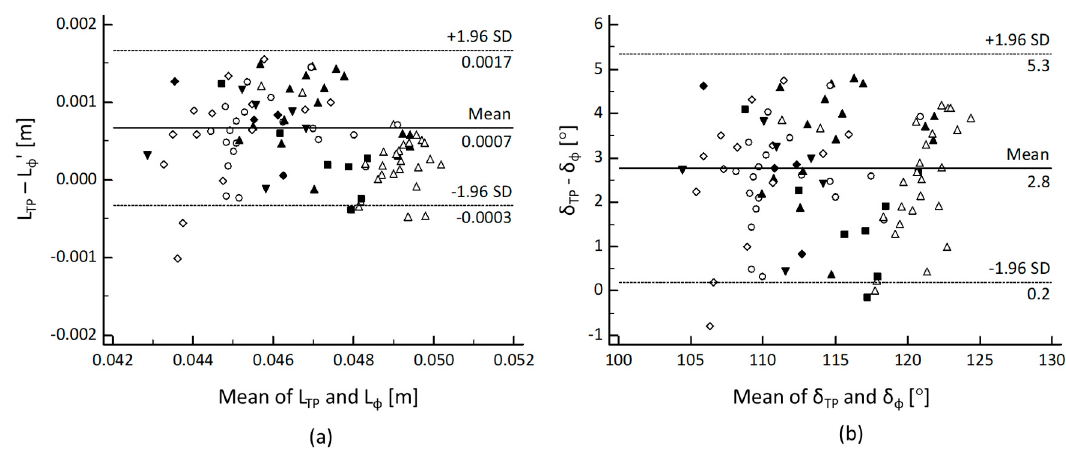
Figure 7. Bland–Altman plot analysis for repeated measurements depicting the absolute agreement between the back extensor muscle moment arm ( a ) and line of action ( b ) as predicted using TP and φ . Horizontal lines represent the bias (solid) and upper and lower limits of agreement (dotted). SD = standard deviation.